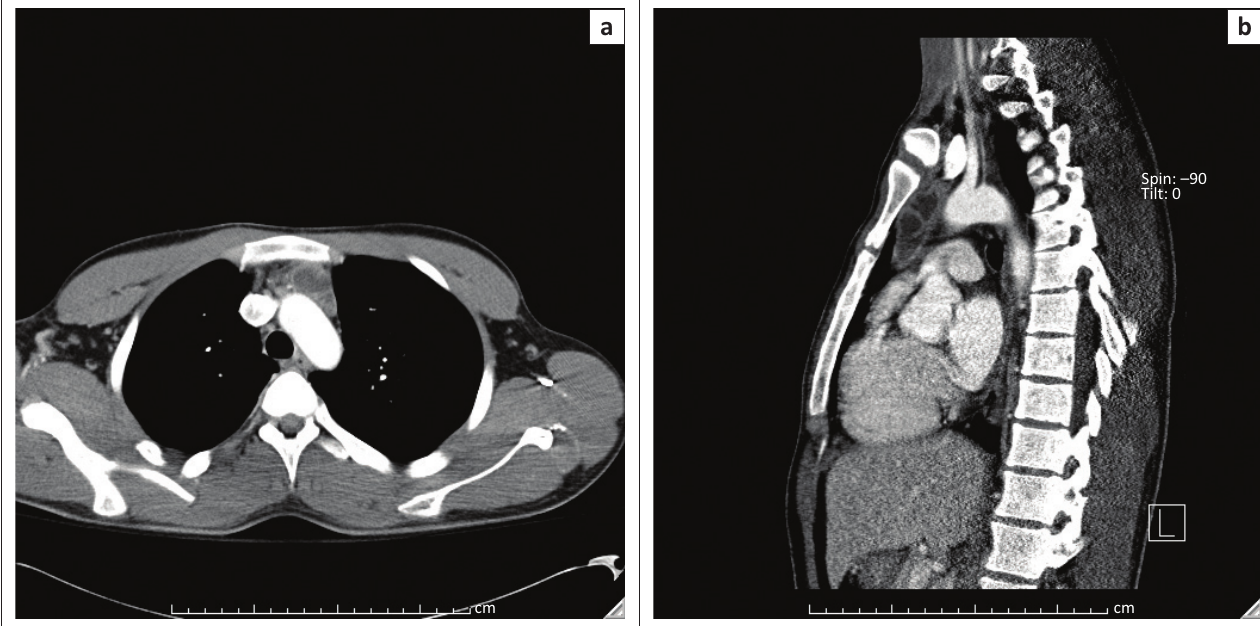
FIGURE 3: Axial (a) and sagittal (b) contrast enhanced computed tomography imaging of the chest demonstrates a well-defined cystic and solid mass containing punctate calcifications in the anterior mediastinum, without mass effect on the adjacent vascular